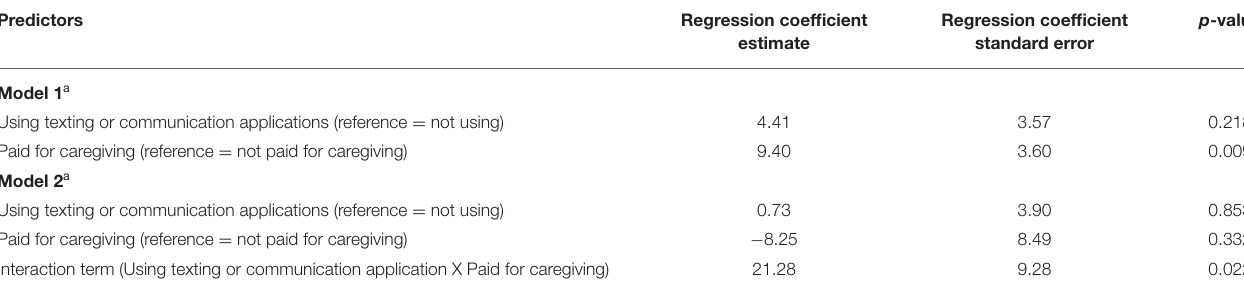
TABLE 2 | Sense of belonging based on caregivers’ payment status and use of communication technologies. Predictors Regression coefficient